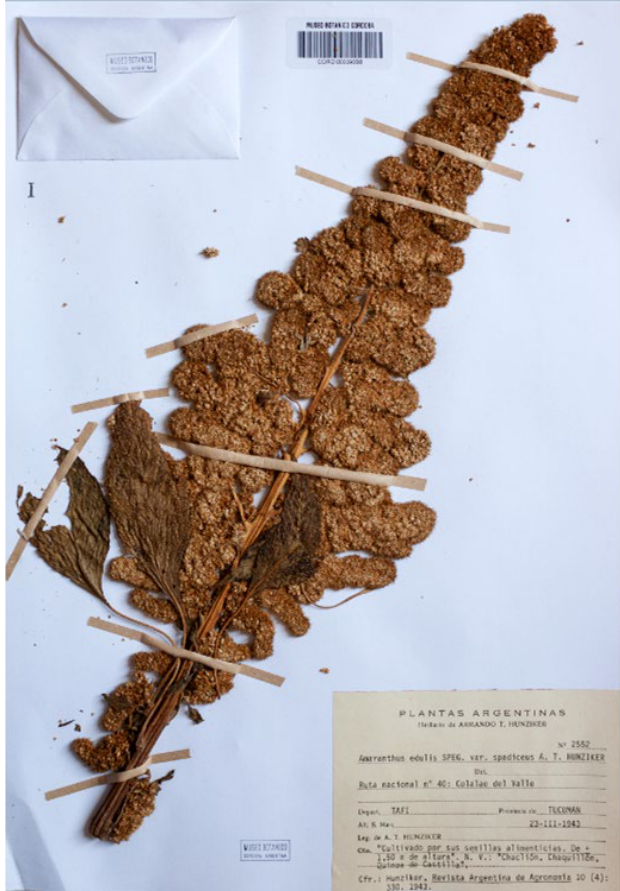
Figure 8. Holotype of the name Amaranthus edulis var. spadiceus (CORD00009356).